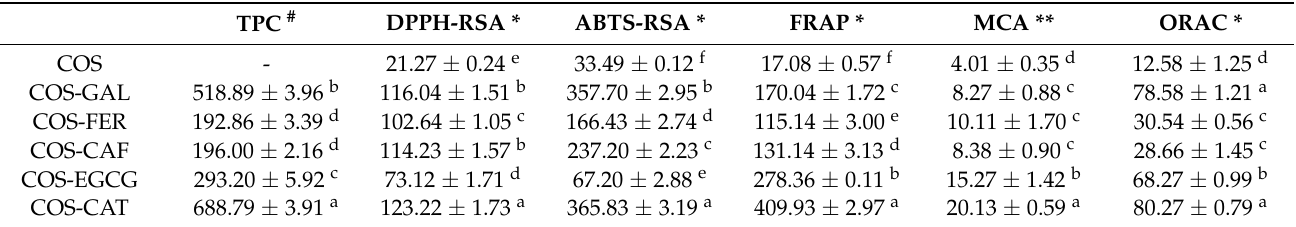
Table 2. Total phenolic content and antioxidant activities of chitooligosaccharide and its conjugate with different phenolic